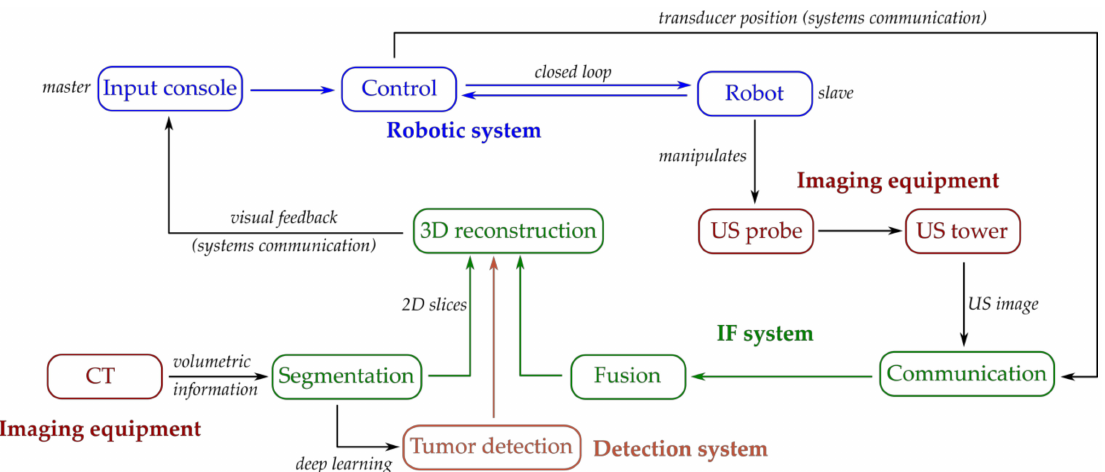
Figure 3. The implementation of the tumor visualization and detection system into the robotic system (general